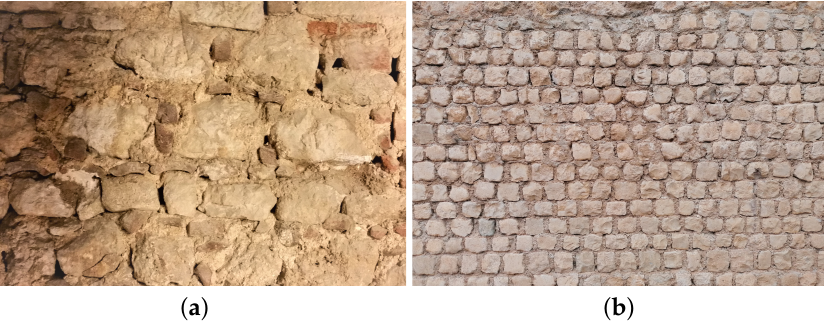
Figure 8. Texture of the masonry, after the restoration of the belfry ( a ) and of the nave wall ( b